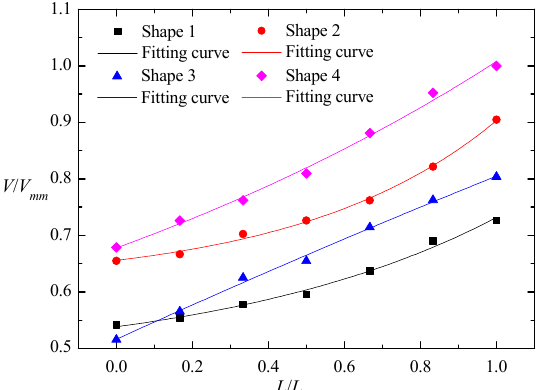
Figure 4. Nappe wind distribution in the longitudinal direction in the physical model test. V mm is the maximum velocity among four shapes.